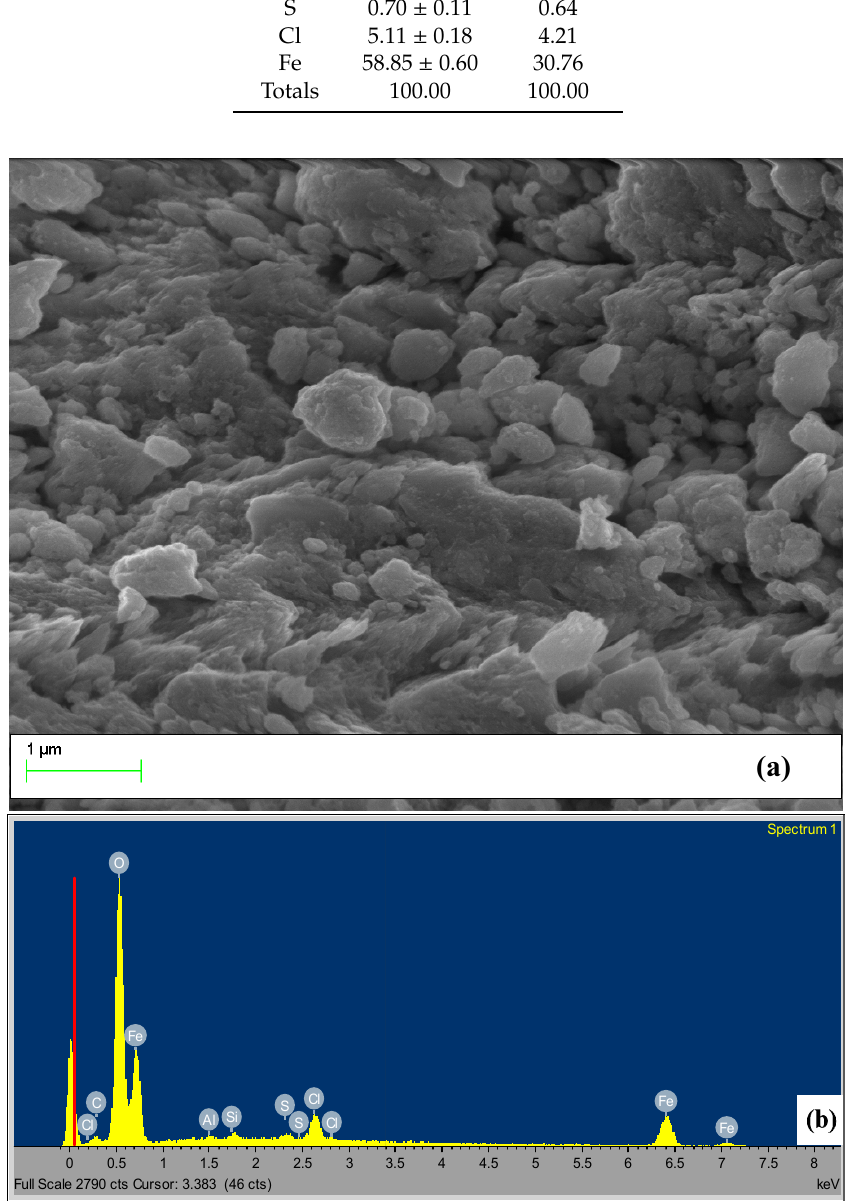
Figure 3. SEM analysis of the goethite nanoparticles: ( a ) SEM image, ( b ) EDX elemental mapping.